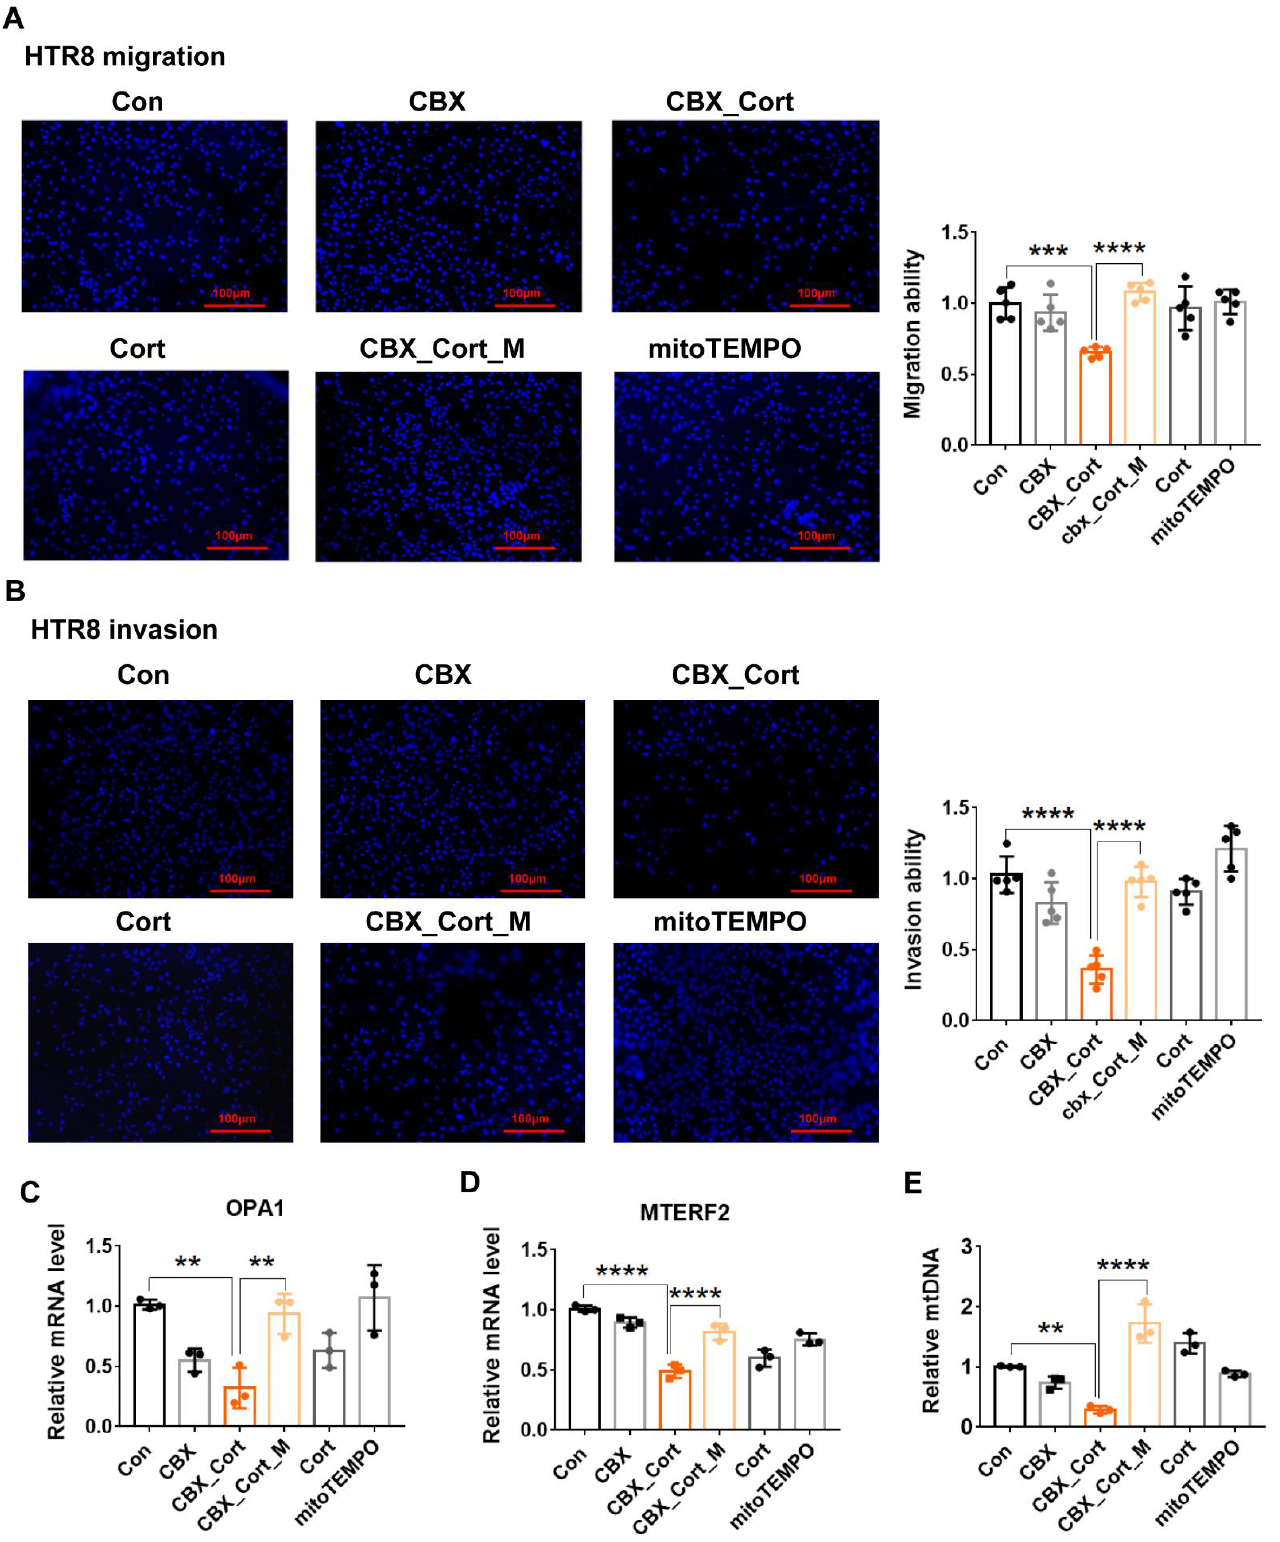
Figure 6. MitoTEMPO treatment improves impaired migration and invasion function, MtDNA maintenance and mitochondria dynamic caused by 11β -HSD2 dysfunction in EVTs. HTR8 cells were treated with cortisol (10 −6 M), CBX (10 −6 M), mitoTEMPO (10 − 7 M) or their combination for 24 to 48 h. The cells were then used for the migration and invasion analysis as described in Methods. In some cases, cells were harvested for Q-PCR analysis. ( A ) the migration function analysis. Left panel : the fluorescence microscopic images show that the cells moved to the underside of the